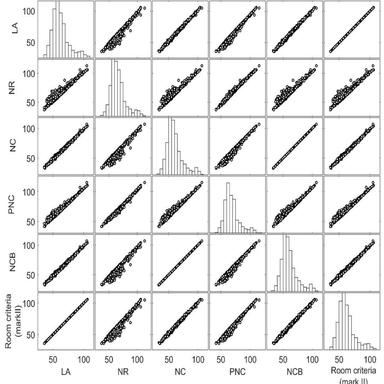
Comparison of different noise indexes applied to all the considered spectra. Histograms for each noise index are included in the main diagonal of the figure.